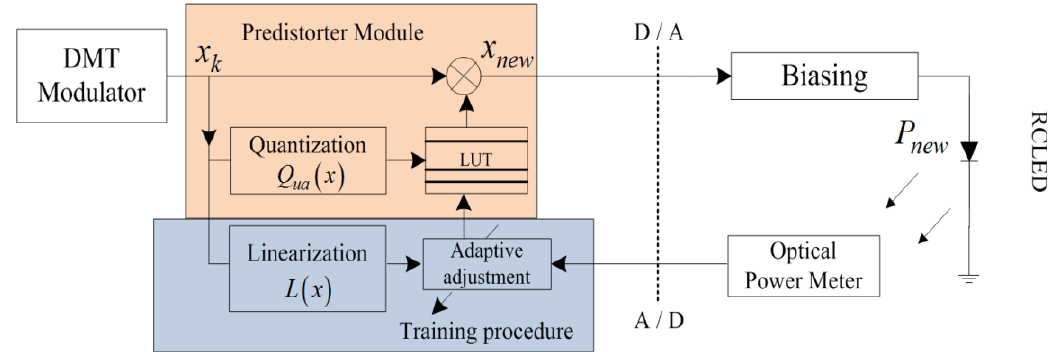
Figure 5. Block diagram of the digital look ‐ up ‐ table (LUT) pre ‐ distorter in the discrete multi ‐ tone (DMT) transmitter.